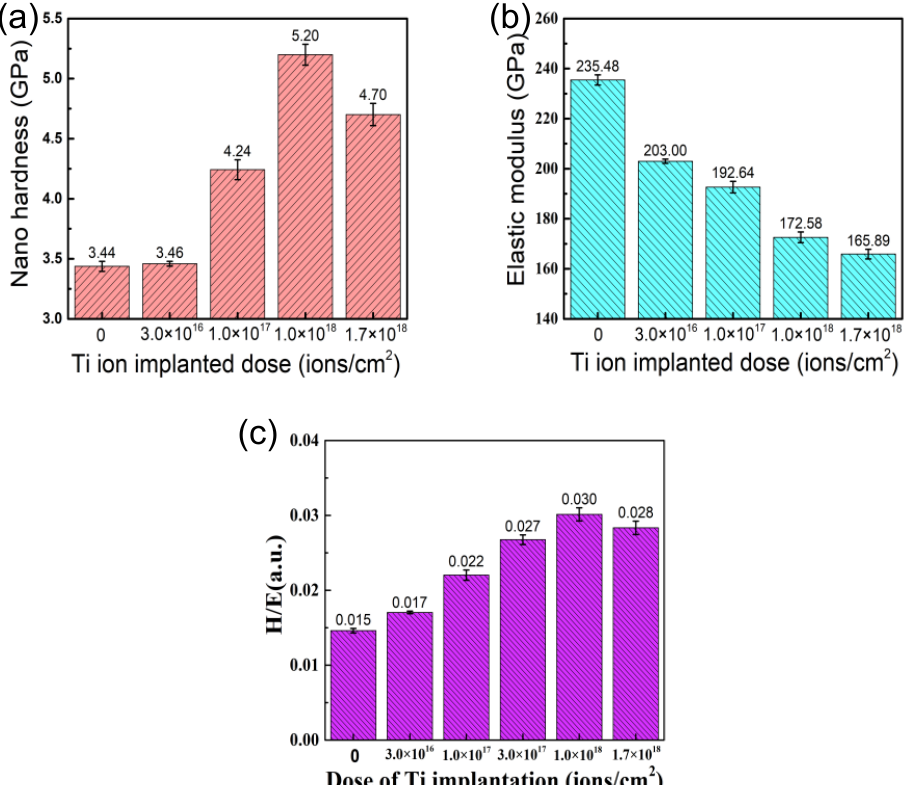
Figure 6. Mechanical properties of 316L stainless steel samples with different Ti ion implantation doses: ( a ) the surface hardness, ( b ) the surface elastic modulus, and ( c ) the ratio of hardness to elastic modulus ( H / E ).